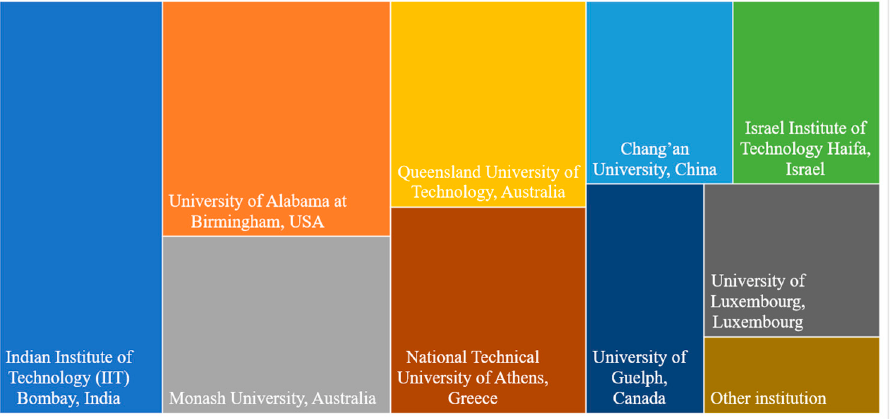
Figure 3. Distribution of papers by research institution.